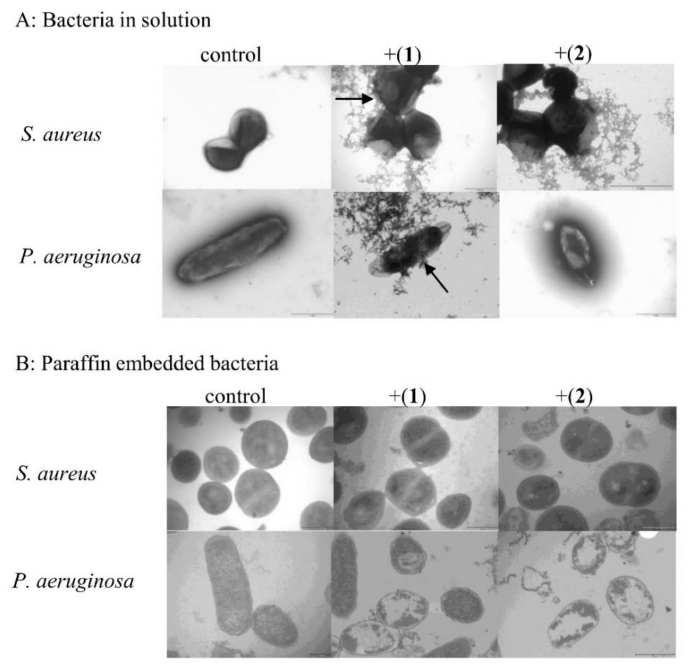
Figure 3. Changes in the cell morphology of S. aureus and P. aeruginosa cells treated with [CoCl 2 (dap) 2 ]Cl- ( 1 ) and [CoCl 2 (en) 2 ]Cl- ( 2 ). Microscopic preparations prepared in solution and as paraffin-embedded bacteria. Transmission electron microscopy images of S. aureus ATCC 6538 and P. aeruginosa ATCC 9077 in the absence (control) and presence of Compounds ( 1 ) (+( 1 )) and ( 2 ) (+( 2 )). Magnification 20,000 × .